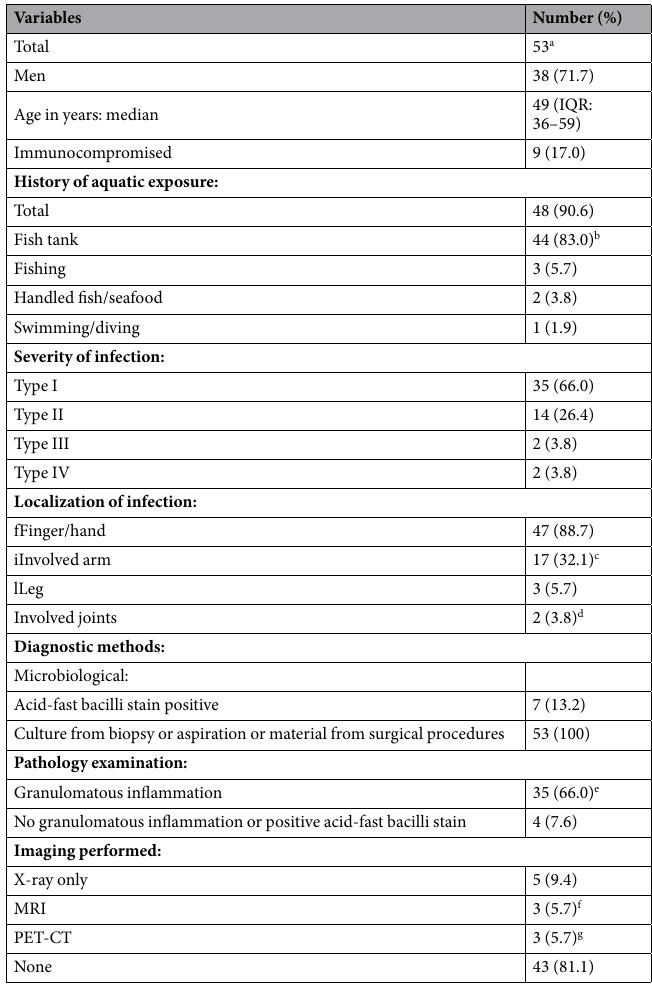
Table 1. Characteristics and diagnostic methods used in patients with M. marinum infection in Denmark. a Two patients with missing medical records were left out of the analyses. b Two patients reported exposure to fish tank and fishing. c Fifteen patients had involvement of finger/hand and arm. d One patient had involvement of joint and finger/hand and arm. e Forty-two patients had histological examination performed. f Three patients had X-ray and MRI performed. g Three patients had X-ray and PET-CT performed, one patient had X-ray, MRI and PET-CT